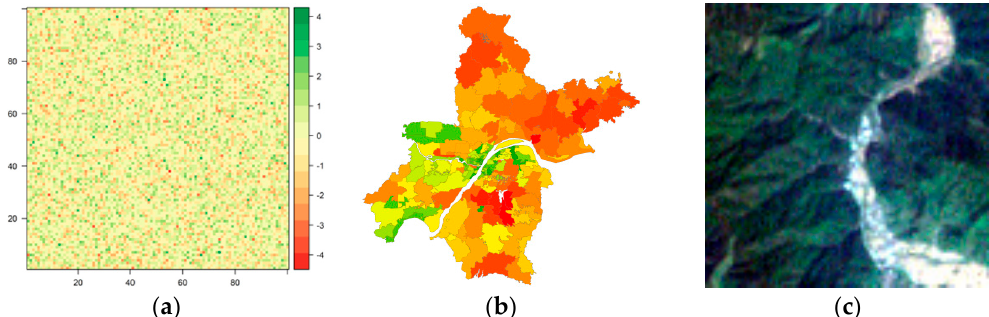
Figure 7. Landscapes with different degrees of spatial autocorrelation (SA): ( a ) a 100-by-100 lattice across which pseudo-random numbers from a standard normal distribution are randomly distributed; ( b ) 184 census blocks of Wuhan (2010) with 0–19% (ranging from 7.83 to 39.74, with green representing low rates and red representing high rates) displayed; ( c ) 100-by-100 pixels clipped from the Yellow Mountain region image (2002, with the green representing vegetation and buff-to-white strips depicting mountain ridges).